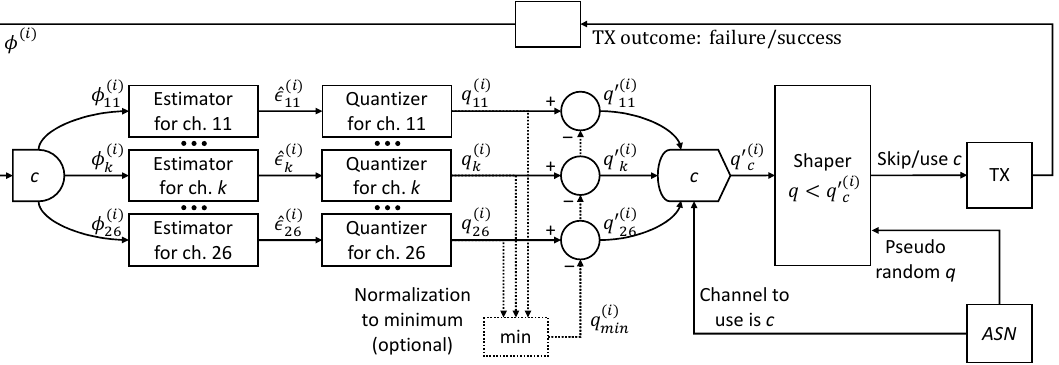
Figure 1. Block diagram for ACCS (including optional normalization to the minimum): the MAC of TSCH is instructed whether to use or to skip every cell allocated to the